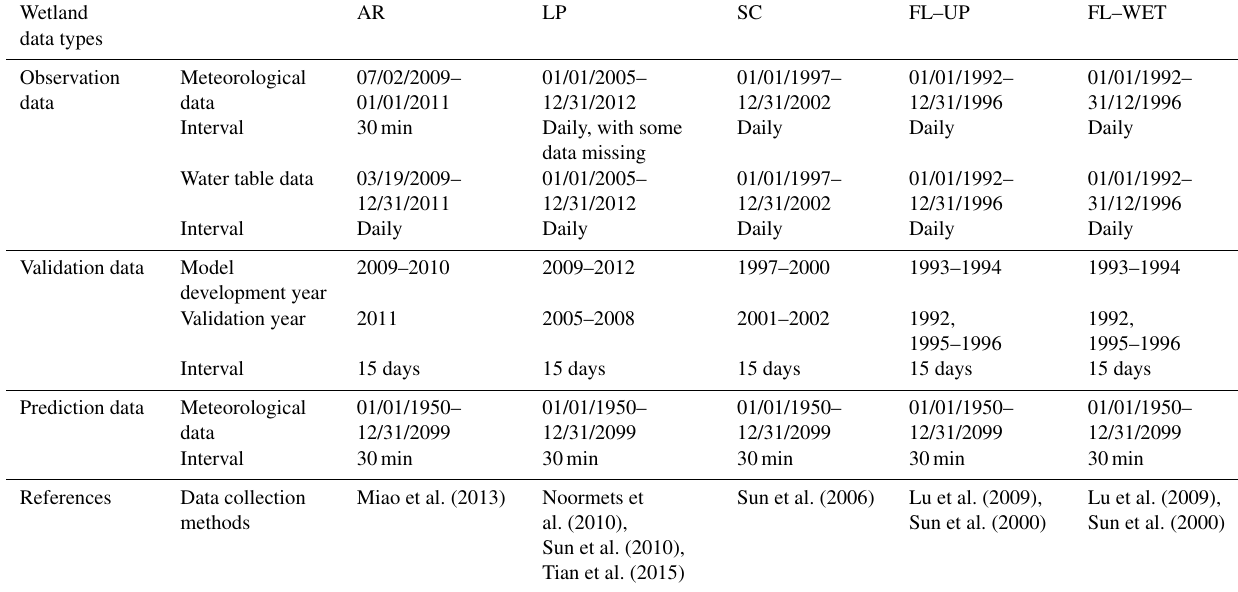
Table 2. Raw data